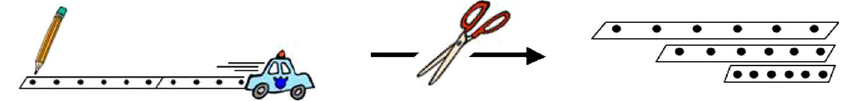
FIG. 1 (color online). Schematic for how ticker tape strips were produced prior to